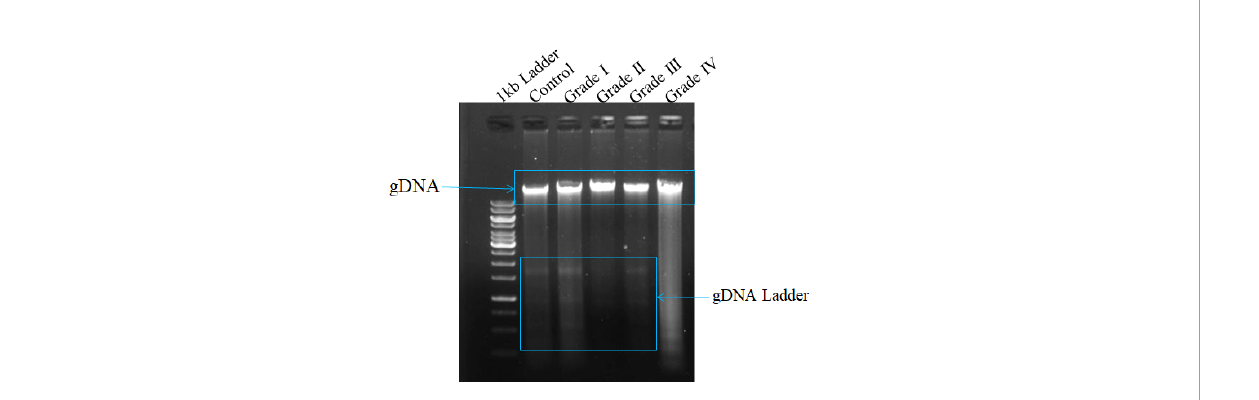
FIGURE 2 Measurement of apoptosis in different grades of glioma with comparison to control tissue on surgically excised tissue sample using DNA ladder assay. The formation of DNA fragments in the form of a ladder describes the occurrence of